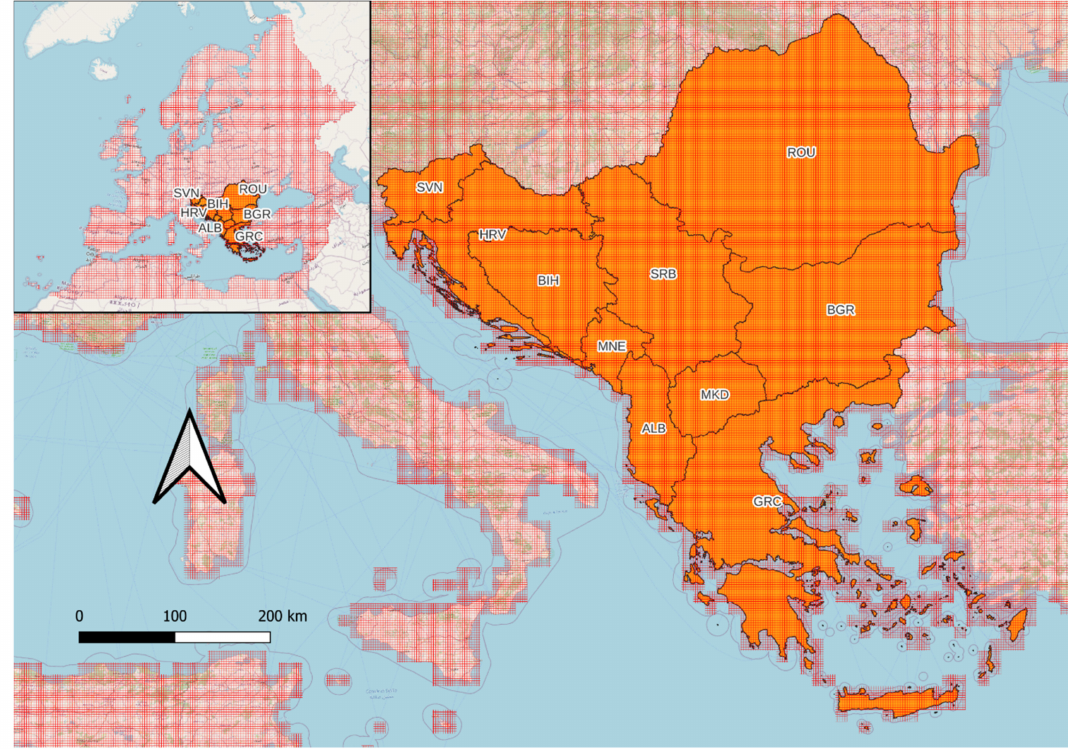
Figure 1. The Agri4Cast grid (red colored) coverage and the study area (orange colored in the zoom